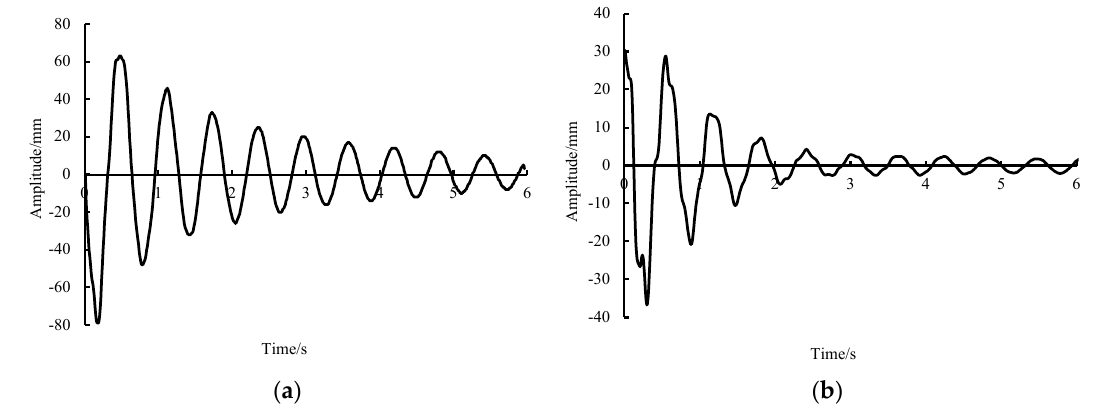
Figure 9. Damped free vibration signal of the rape plant. ( a ) Lateral branch. ( b ) Main branch. According to the formula of exponential attenuation of amplitude [30]: